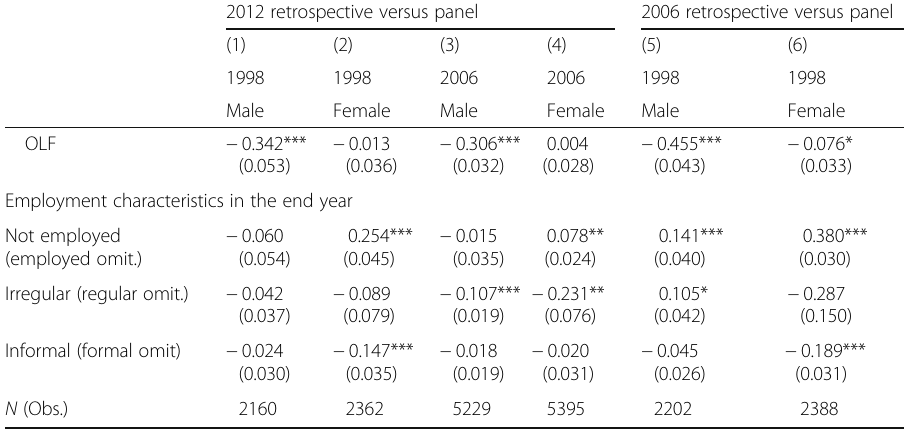
Table 3 Probit model marginal effects for the probability of alignment of labor market status between contemporaneous 1998 or 2006 and 2012 or 2006 retrospective data by sex, individuals in base year (1998 or 2006) and present in the other waves, aged 20 – 44 in base year of the pair (Continued)